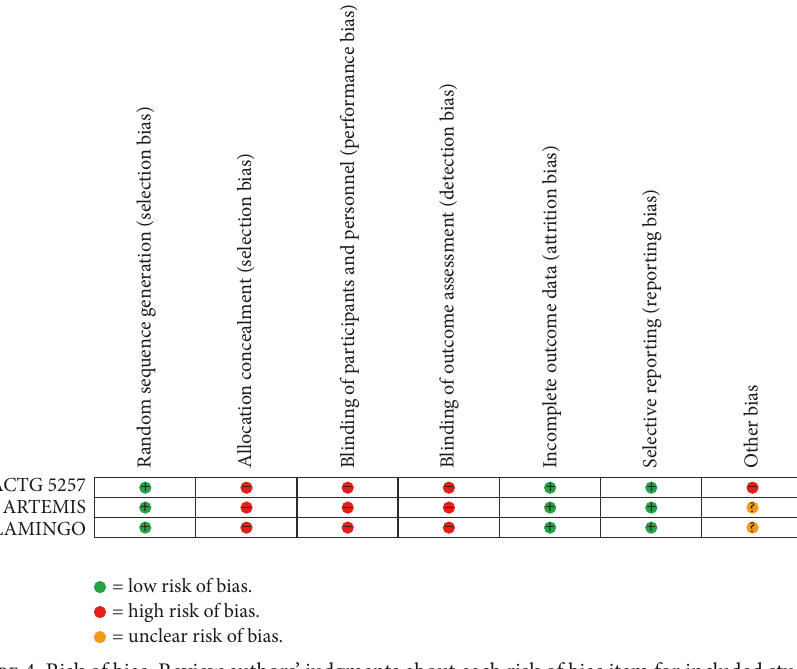
Figure 4: Risk of bias. Review authors’ judgments about each risk of bias item for included